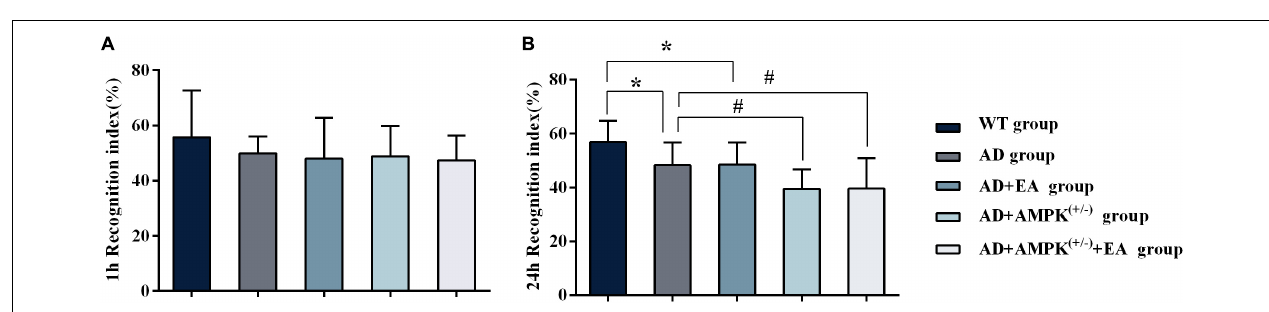
FIGURE 2 | Novel object recognition test showing decreased recognition index for the novel object in 4-month-old APP/PS1 mice. (A) The 1 h recognition index of five groups before EA intervention; (B) The 24 h recognition index of five groups before EA intervention. * P < 0.05 vs. the wild type (WT) group; # P < 0.05 vs. the Alzheimer’s disease (AD)